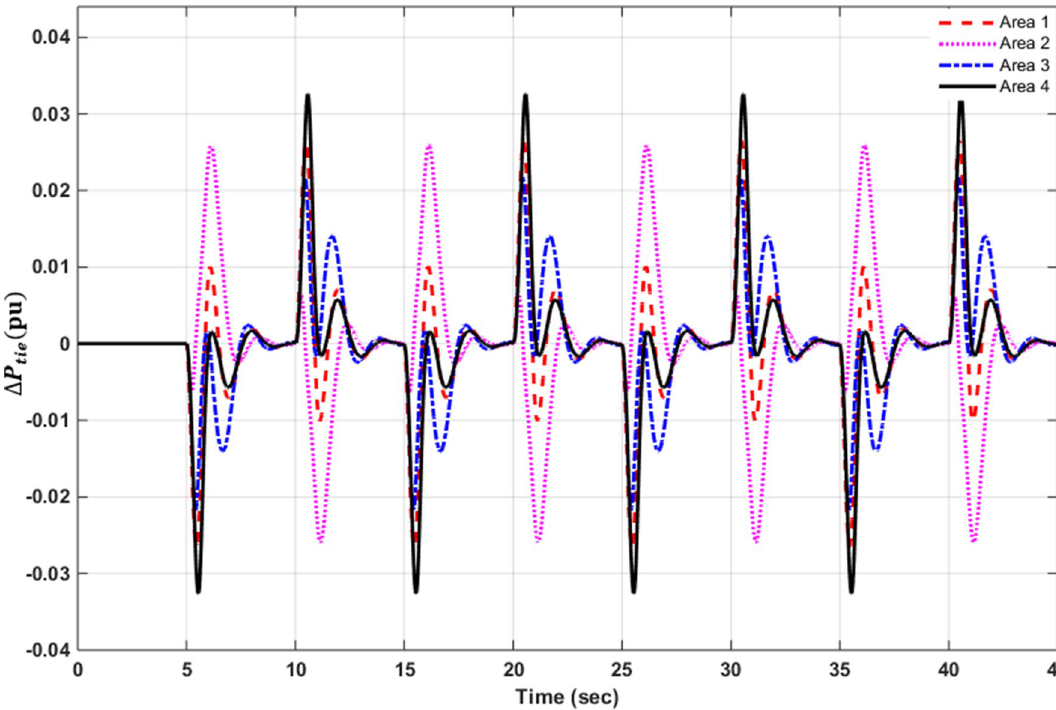
Figure 9. OQAGC Tie-line deviations for four area power systems with load